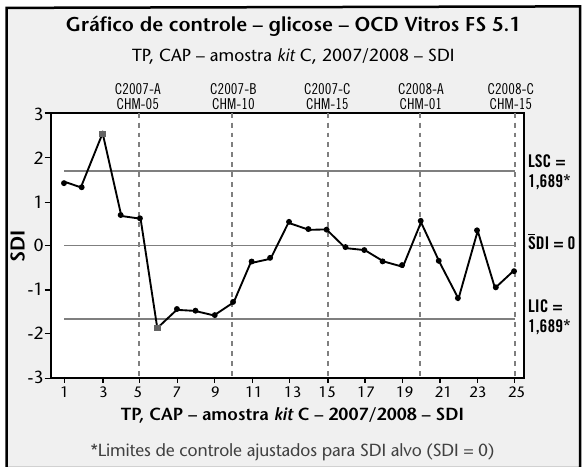
Figura 4 – Análise de inexatidão de longo prazo: gráfico de controle (Shewhart), glicose Vitros FS 5.1, SDI TP, CAP, kit C,